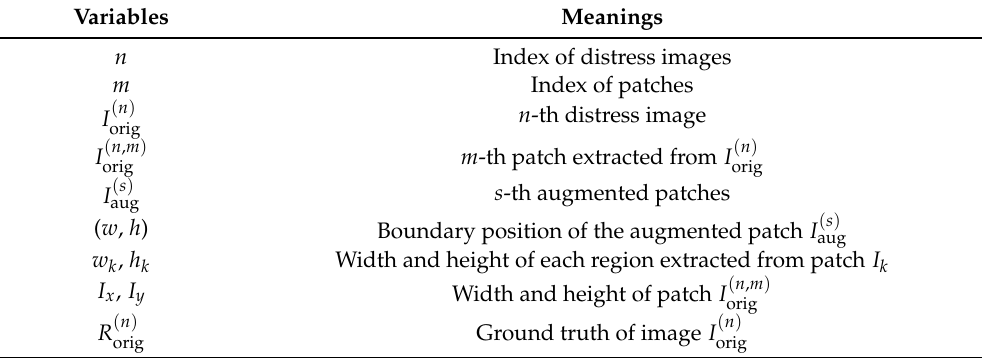
Table 1. Explanation of the mathematical variables and